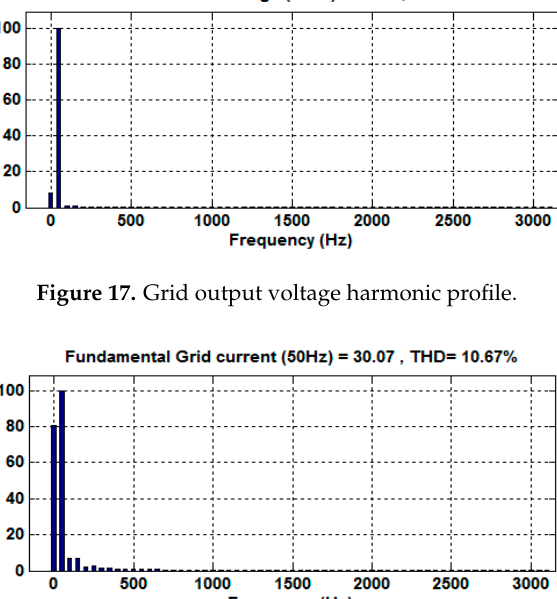
Figure 18. Grid injected current harmonic profile.